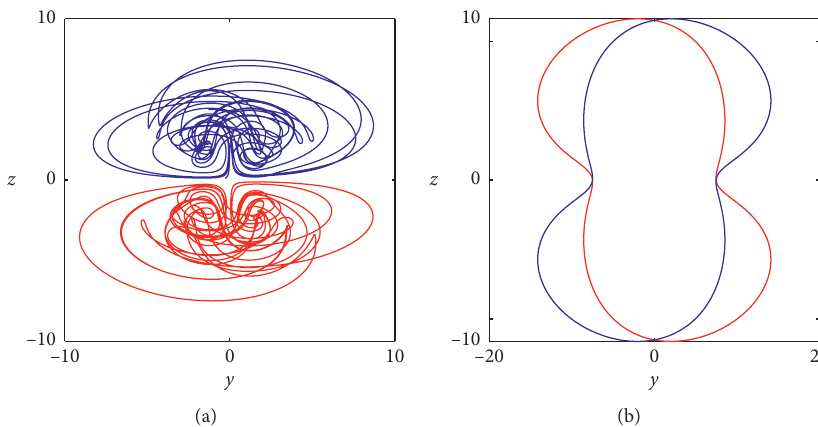
Figure 8: Various coexisting attractors in the y − z plane under initial conditions [ 1 , 1 , ± 1 , 1 , 1 , 1 ] : (a) coexistence of two-wing chaotic attractors and (b) coexistence of limit cycles.